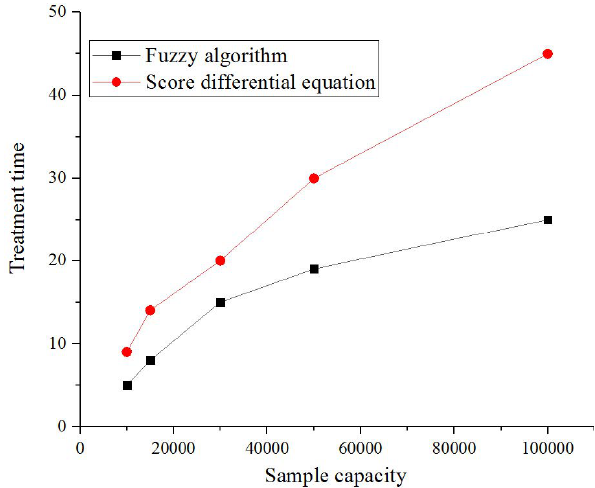
Fig. 3 Comparison of experimental